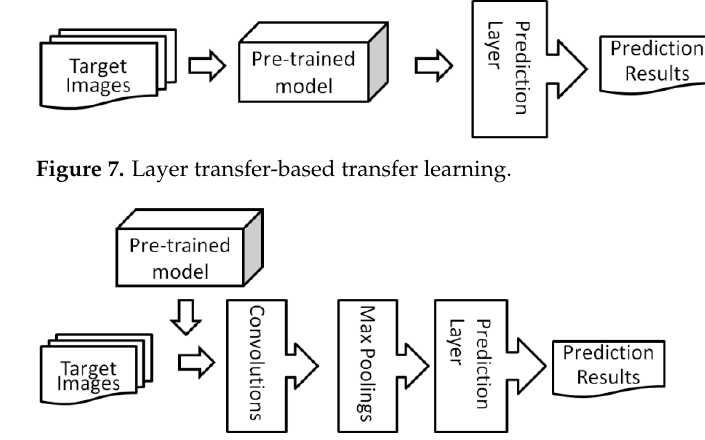
Figure 8. Fine-tuning-based transfer learning.